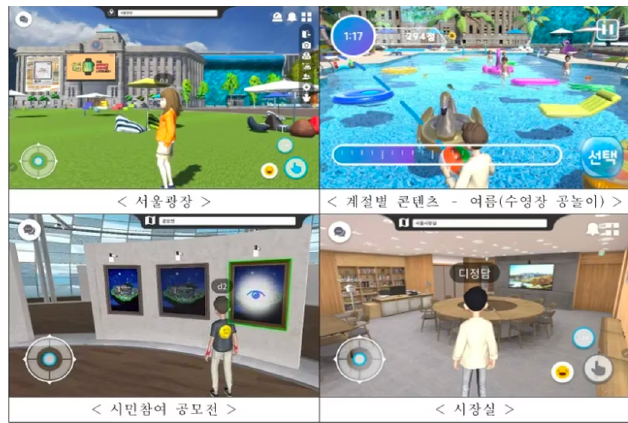
Figure 4: Metaverse Seoul (opengov.seoul.go.kr) The “Cognitive Cities,” Digital Twins, and the NMOs: The Case of “The Line”